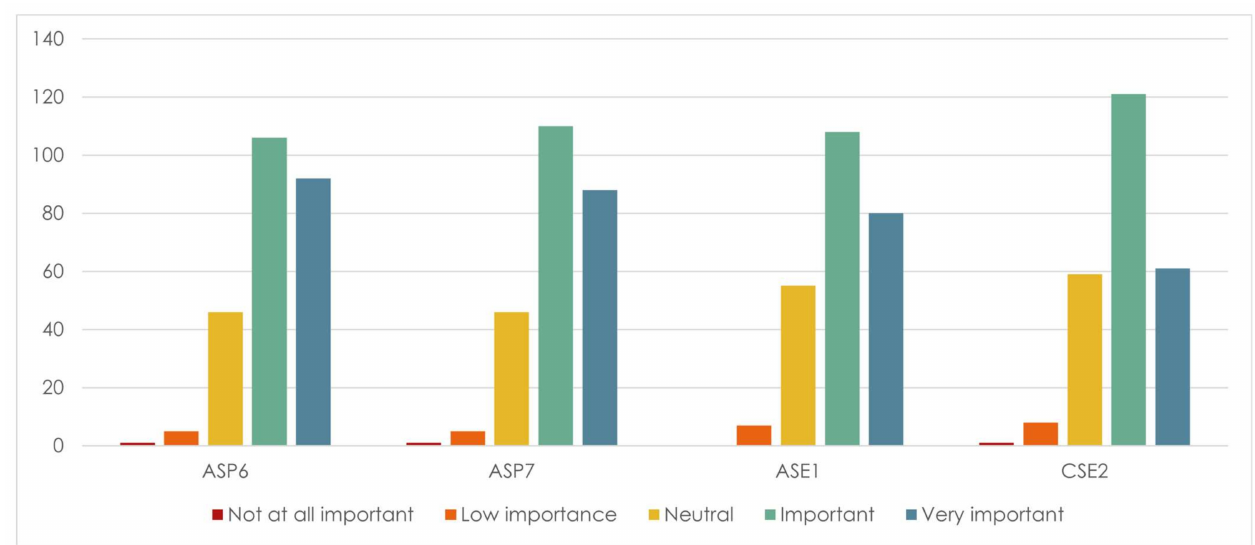
Figure 5. Perceived importance of securing long‑term safety in use .